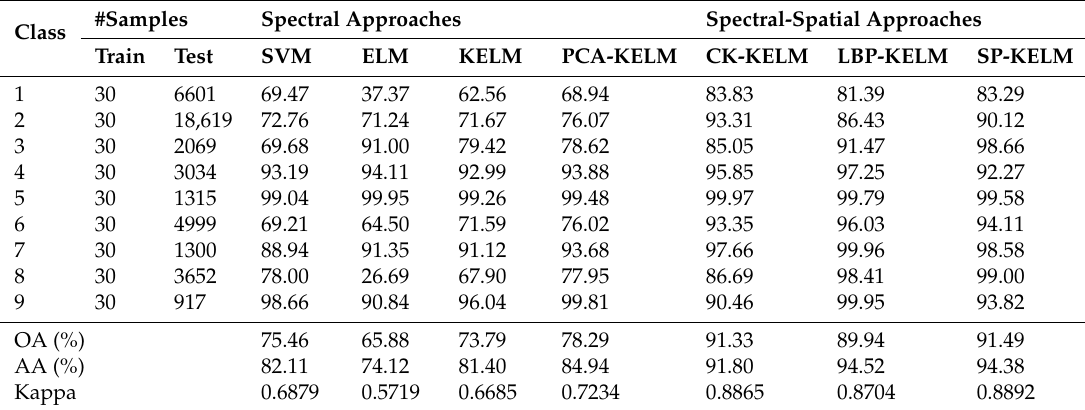
Table 3. Performance comparison of all compared methods on the University of Pavia dataset.